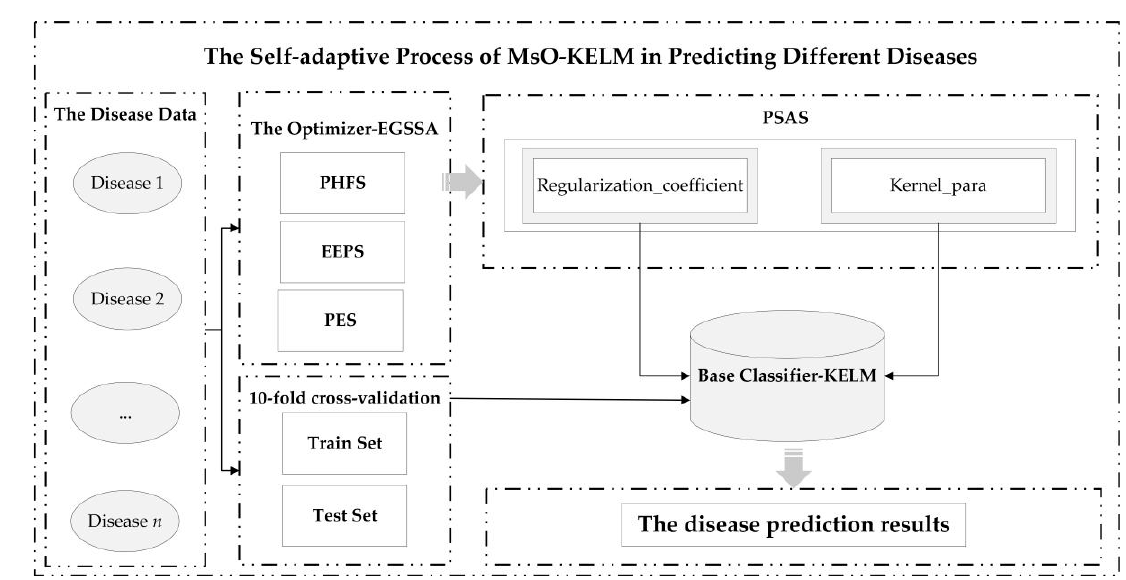
Figure 1. The self-adaptive process of the MsO-KELM in predicting different diseases.